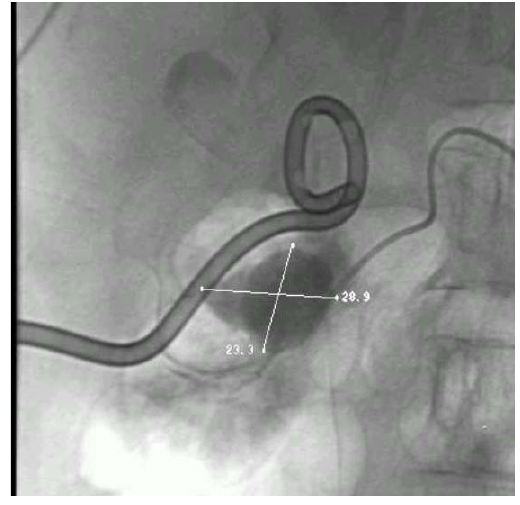
FIGURE 2. Selective renal angiography demonstrating 24 X 29 millimeter pseudoaneurysm of the lower pole segmental artery, just below the nephrostomy stent.